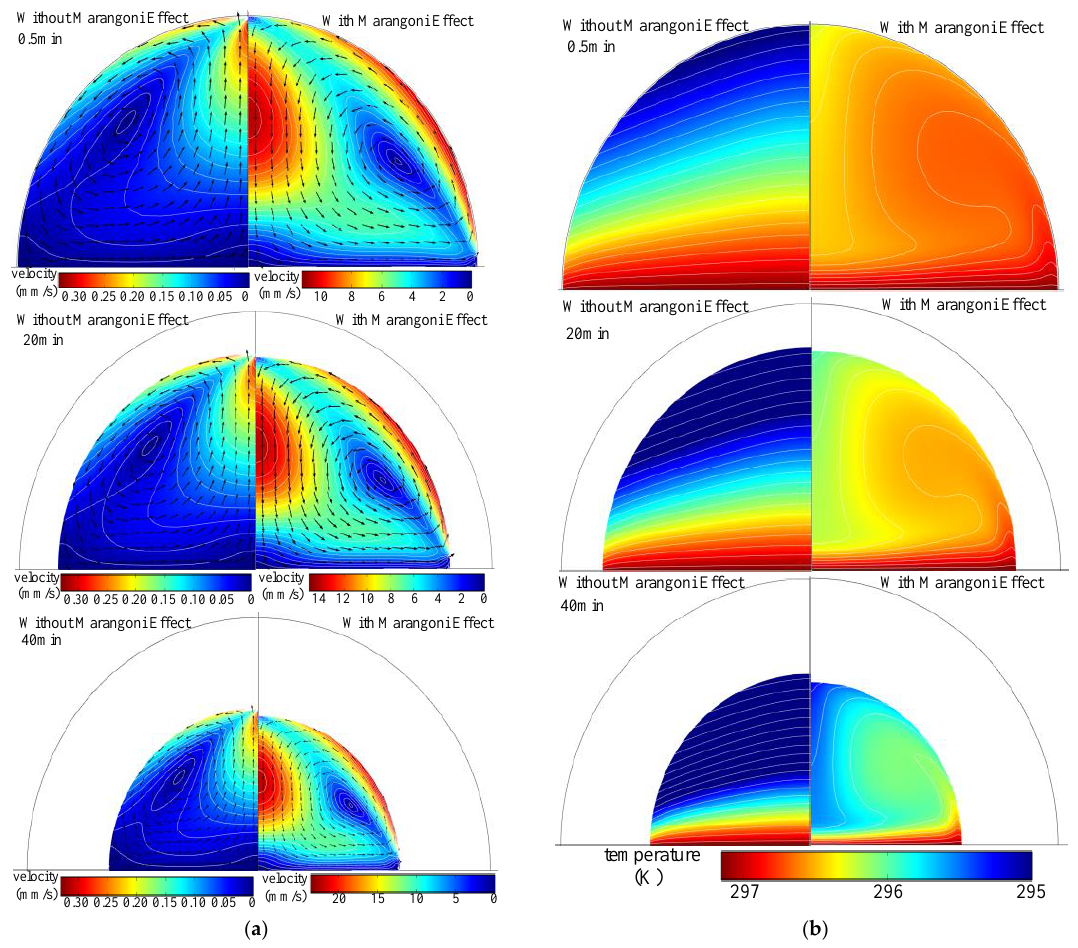
Figure 5. Differences in physical fields within droplets with and without the Marangoni effect. ( a ) Velocity field distribution within the droplet; ( b ) Temperature field distribution within the droplet.